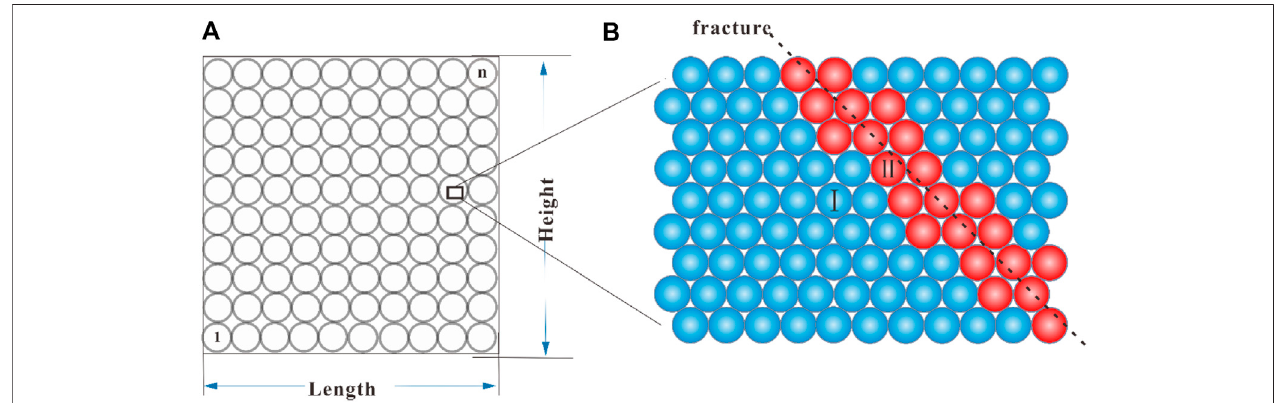
FIGURE4| AmeasurementlayoutforasamplewithLength × Heightinsize. (A) Circularmeasuringwindows. (B) Enlargedviewofacircularwindow.Particleswith normal contacts are indicated in blue and particles affected by fractures are shown in red.